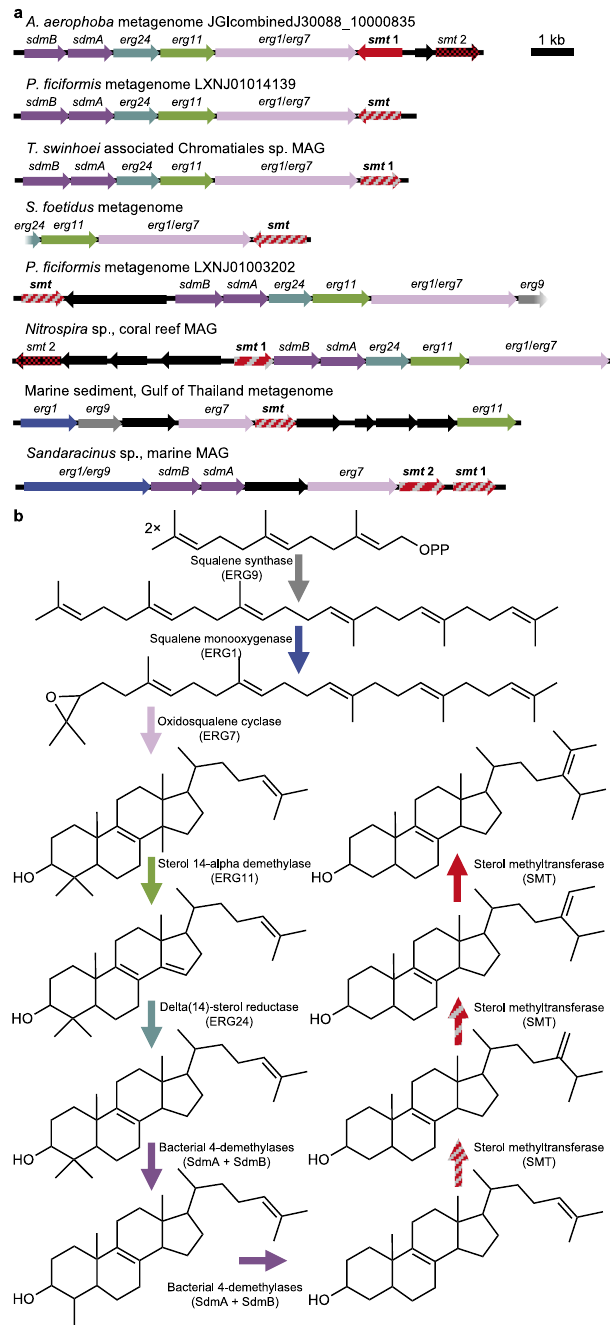
Fig. 3 | Gene clusters suggest de novo side-chain alkylated sterol biosynthesis in the bacterial domain. a Gene clusters identi fi ed in metagenomes and metagenome-assembled genomes (MAGs) containing three or more sterol bio- synthesis homologs and including functional sterol methyltransferases (bold). Genes are named for their Saccharomyces cerevisiae ( erg ) or Methylococcus capsu- latus Bath ( sdmAB ) homologs. Dotted sterol methyltranferases did not methylate desmosterol or 24-methylenecholesterol in vitro. Striped patterns correspond to the number of methylations performed by each sterol methyltransferase in vitro. Gradients indicate partial sequences. b Schematic of a hypothetical bacterial side- chain alkylated sterol biosynthesis pathway. Arrow colors at each step correspond to the homologs identi fi ed in a . Detailed information on the source of each metagenomic gene cluster is available in Supplementary Table 4. Homology for each gene is described in Supplementary Data